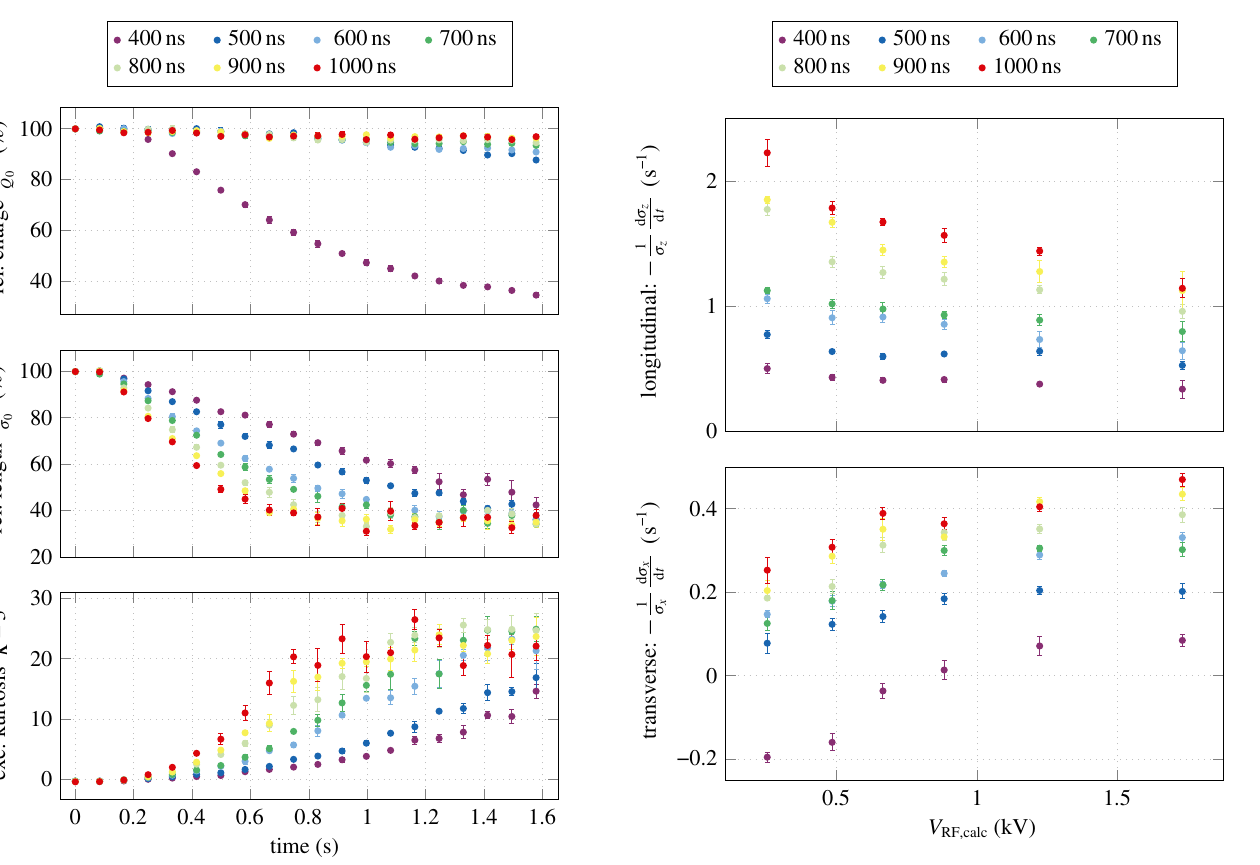
FIG. 16. Longitudinal and transverse cooling rates as a function FIG. 15. Evolution of the statistical properties of the longi- of electron bunch length and rf voltage, calculated in the interval tudinal ion bunch profile as a function of time, averaged over five 0 . 2 s ≤ t ≤ 0 . 4 s and averaged over five identical experimental identical experimental runs per setting. Each color corresponds to runs per setting. The error bars represent the statistical error of one setting of the electron bunch length. The cooling beam is the ¼ 1 kV. The error bars represent switched on at t ¼ 0 . 1 s. V rf ; set the statistical error of the mean.